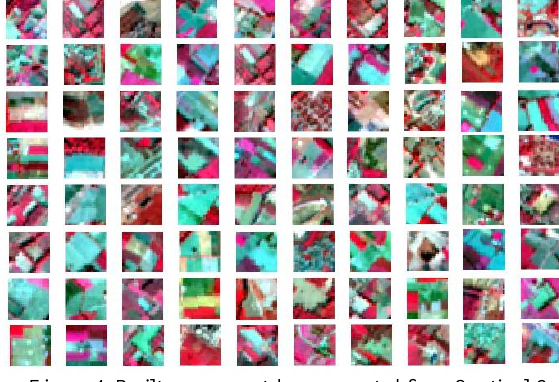
Figure 4. Built-up area patches generated from Sentinel-2 dataset for training and testing networks